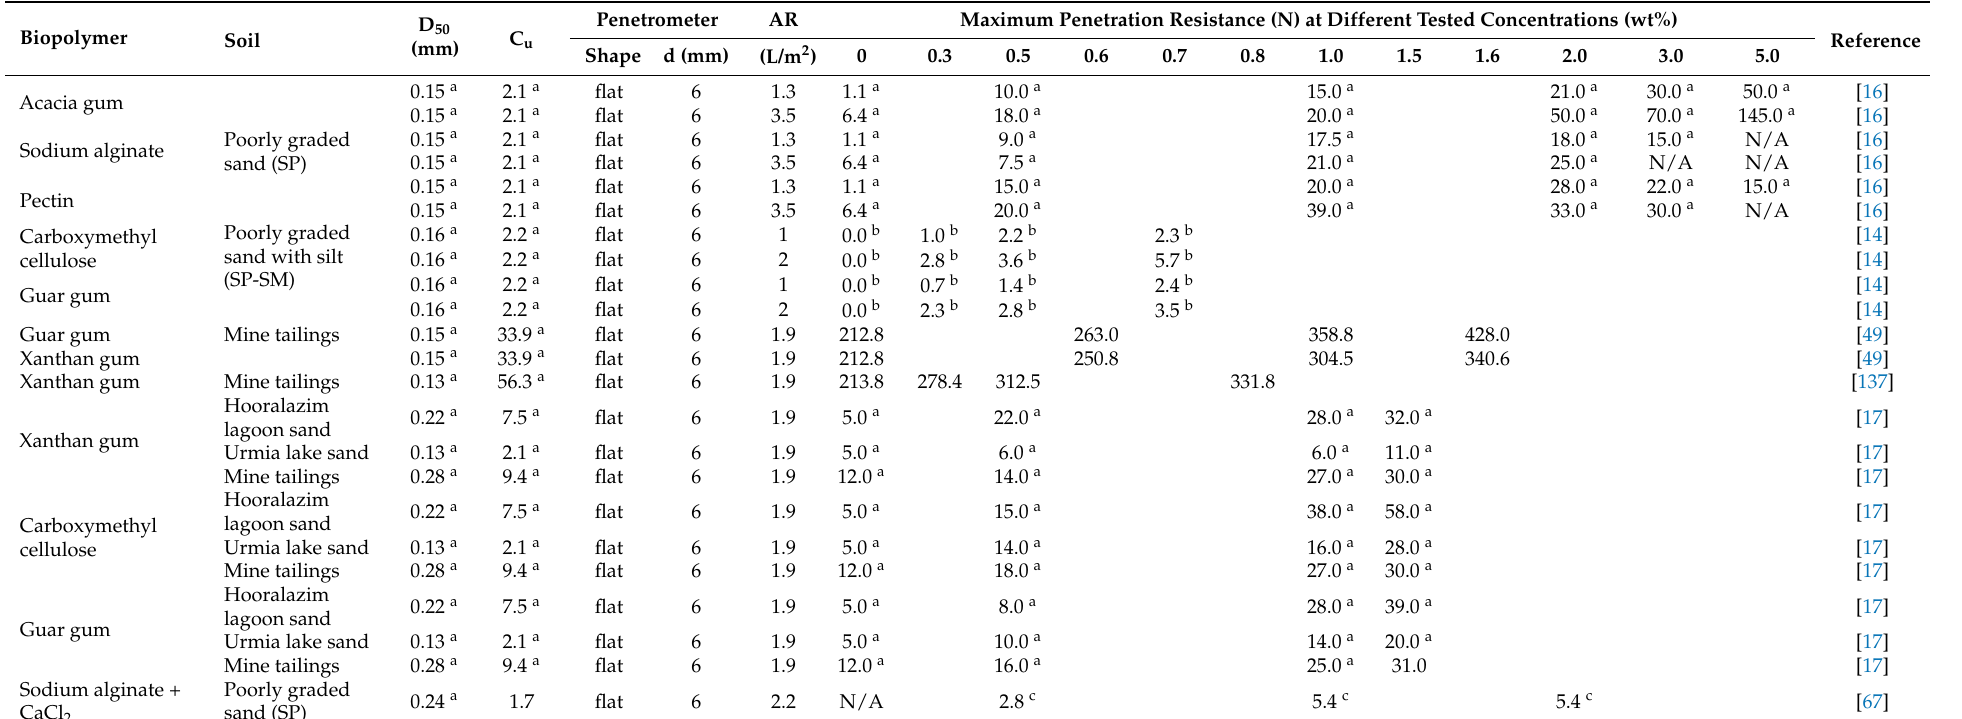
Table A7. Compilation of results from previous studies performing penetrometer testing on different soils to assess the penetration resistance of spray-on biopolymer